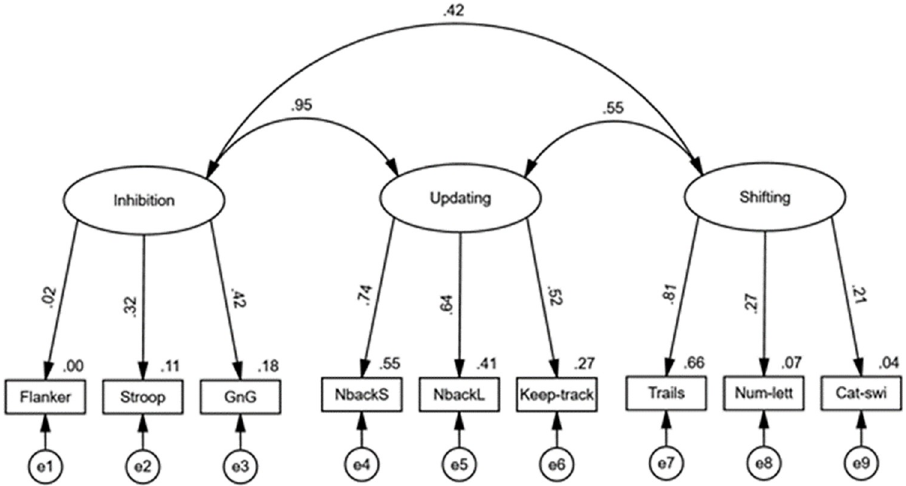
Fig 1. Confirmatory factor analysis of EF-subcomponent latent variables in correlated three-factor model. Note. Straight lines with single arrows are regression paths. The curved lines with double arrows are correlations. The observed variables at the bottom represent EF-task scores. Numbers on top-right of observed variables represent proportion of variance accounted for in each variable. Error terms associated with each observed variable are indicated by e1-9. Factor loadings and correlations are fully